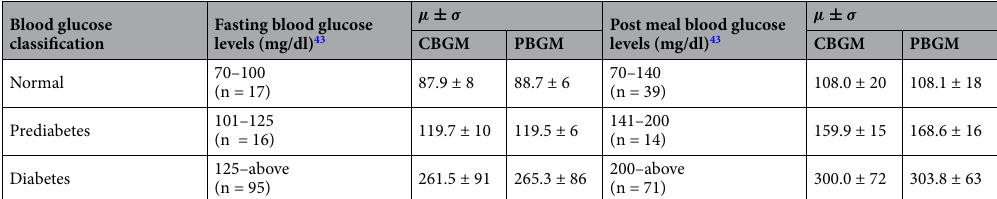
Table 1. Blood glucose level classification with mean ( µ ), standard deviation ( σ ) of CBGM and PBGM.